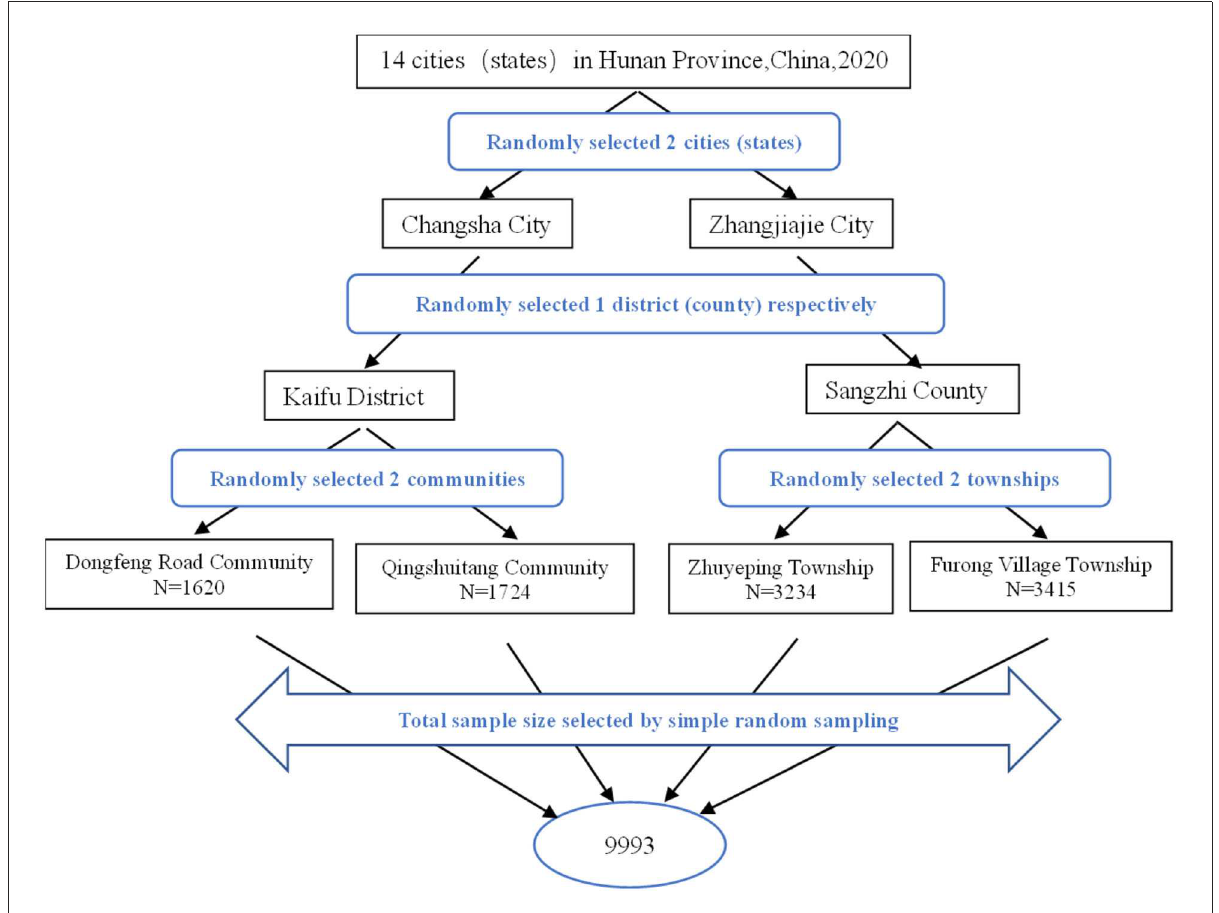
FIGURE1 Flowchart for screening the subjects ( N =